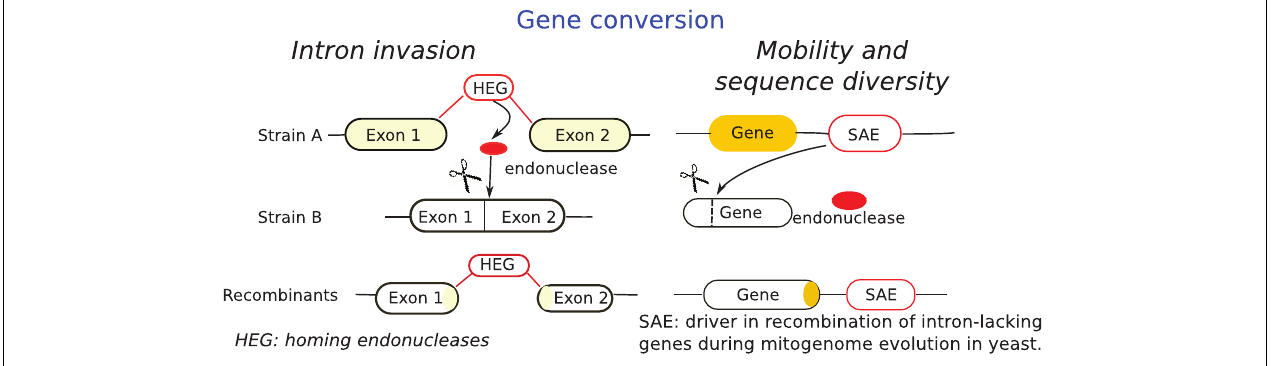
FIGURE 4 | Scheme of gene conversion through intron invasion and mobility and diversification adapted from Wu and Hao (2019). SAE mechanisms, known as intronless homing is compared with intron homing mechanism (HEG). Intron homing is facilitated by intron-encoded endonuclease and occurs into homologous intron-minus genes. SAE occurs in adjacent intron-lacking genes and facilitate gene conversion of their neighboring genes. The horizontal lines indicate endonuclease